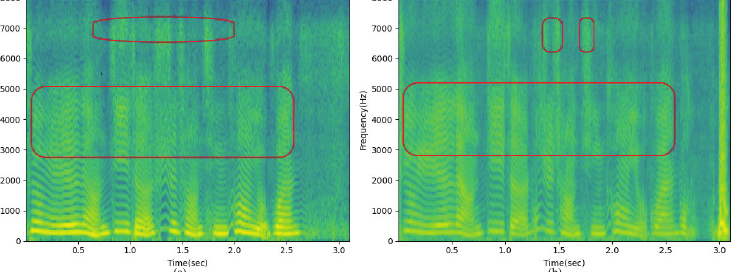
Figure 7. ( a ) Enhanced BC speech spectrogram by CycleGAN. ( b ) Enhanced BC speech spectrogram by StarGAN.